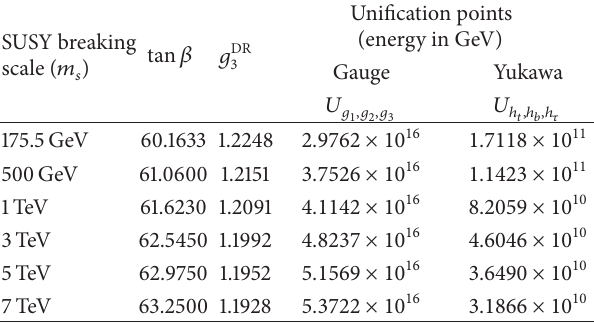
Table 7: Exact unification points for gauge couplings and